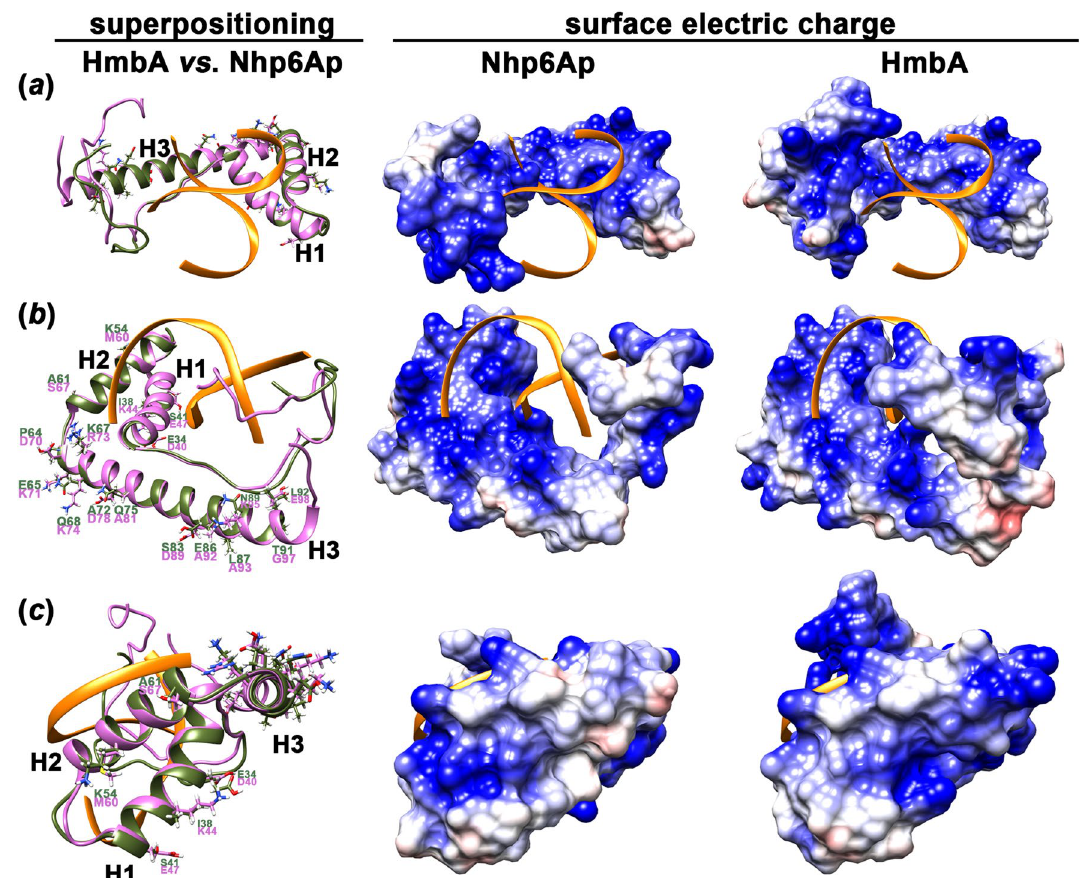
Figure 1. Comparison of the structure and electrostatic surface topography between HmbA and Nhp6Ap. Both models were generated in this work (see “Methods” Section). The yellow ribbon depicts the DNA ligand. The DNA was positioned by superimposing of the NMR-based model structure of Nhp6Ap-DNA complex (PDB ID: 1cg7) with the HmbA and Nhp6Ap models generated in this work followed by hiding the NMR-based Nhp6Ap model and keeping the DNA ligand visible. The left side of each panel shows the superimposition of HmbA (pink ribbon) with Nhp6Ap (olive ribbon) from different angles, whereas the middle and right sides of each panel correspond to Nhp6Ap and HmbA, respectively and show the electrostatic potential of the exposed molecule parts. AA residues that differ between the helices of HmbA and Nhp6Ap are indicated by showing their side chains in stick view. ( a ) The DNA binding interface is shown. None of the altering AA residues map to the DNA binding interface. ( b ) H2 and H3 helices are shown as well as the N-termini and the negatively charged C-terminus that is characteristic only to HmbA. ( c ) H1 and H2 helices are shown. H3 helix is shown from a top view, which illuminates that the altering AA residues are positioned to the surface of the molecule. H1, H2